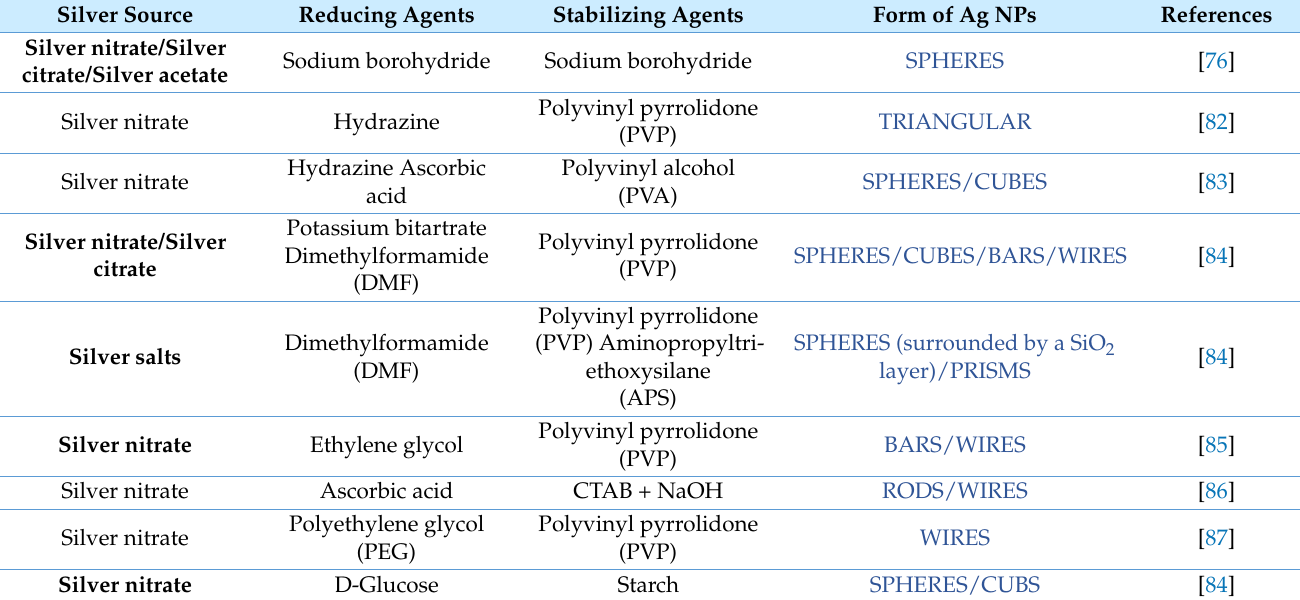
Table 2. Chemical reduction method for silver nanoparticles synthesis using various chemical agents.